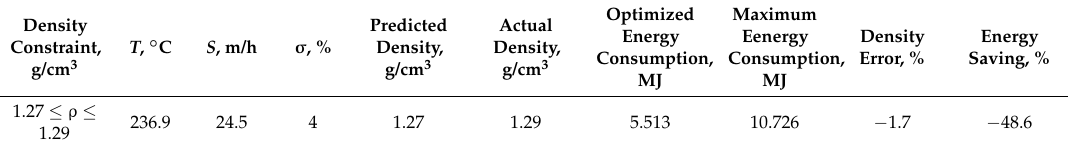
Figure 5. Position of the optimized energy criteria based on density constraint of 1.27 g/cm 3 ≤ ρ ≤ 1.29 g/cm 3 . Table 5. Optimized operational parameters ( T , S , and σ ) and the corresponding minimum energy consumption based on the given constraints, and using the GA optimizer; the SVR predictive modeling was used for density.